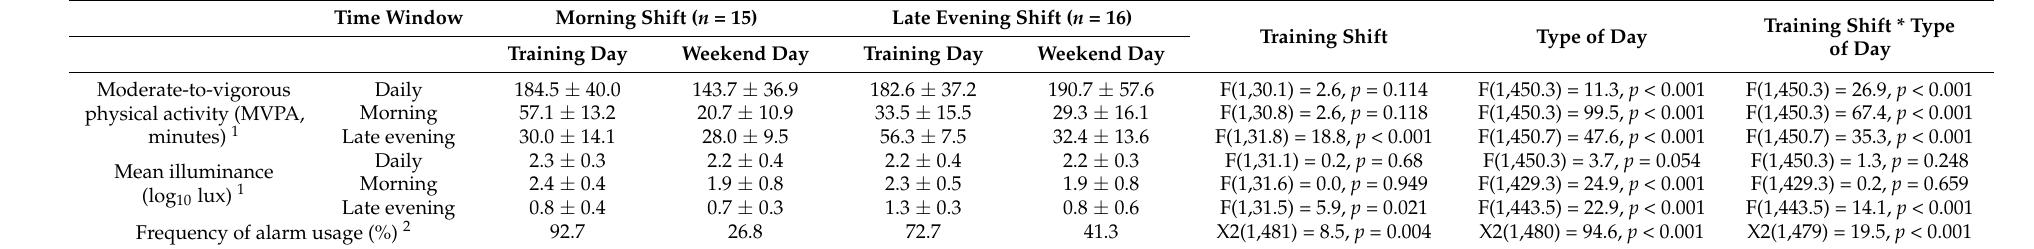
Table 2. Alarm usage, light exposure, and physical activity in morning and late evening shifts, on training and weekend